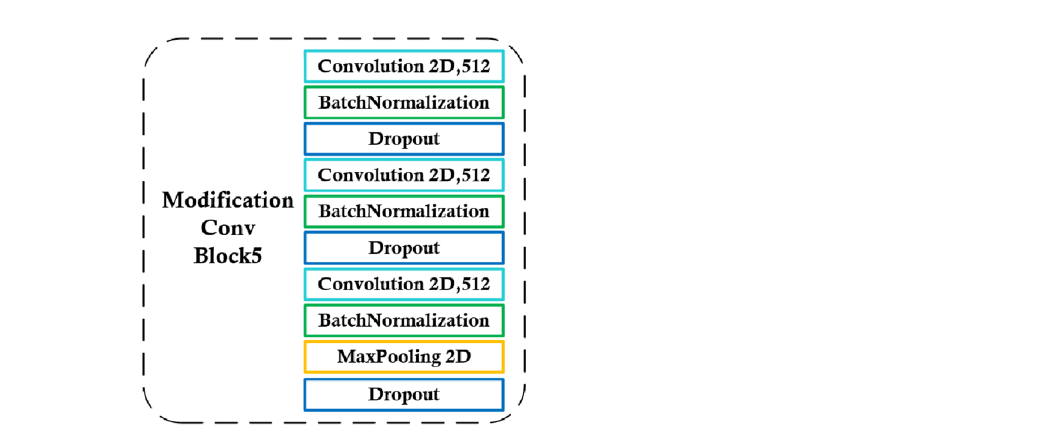
Figure 10. Modification of Conv Block-6 of VGG-16 neural network